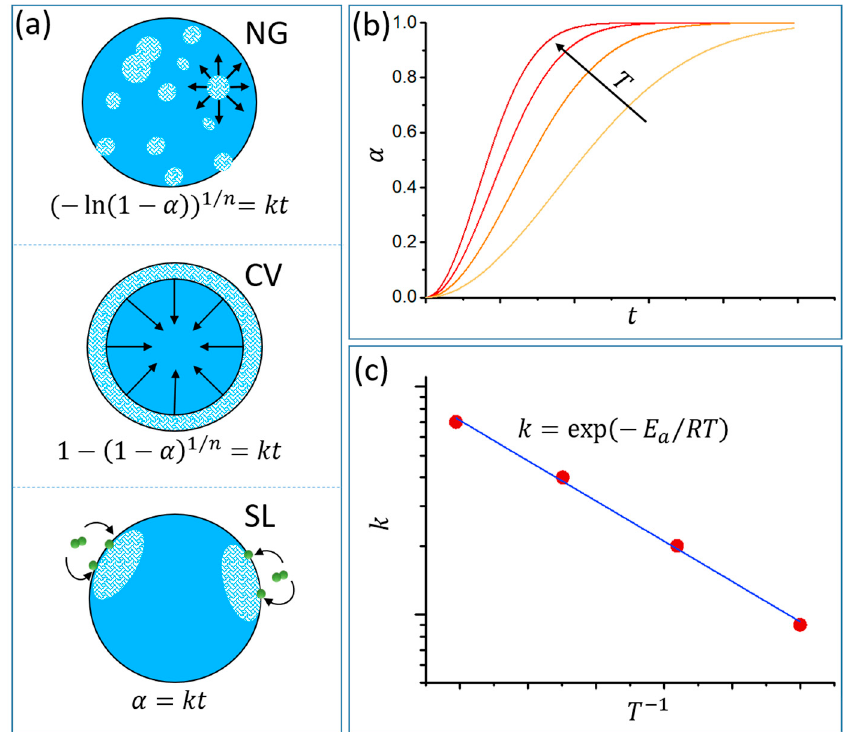
Figure 2. ( a ) Representation of the kinetic models used to analyze the time evolution of the transformed fraction α : nucleation and growth (NG), contracting volume (CV), and surface limited (SL). ( b ) Example of NG kinetics at increasing temperature T . ( c ) Arrhenius plot of the rate constant k , from which the apparent activation energy E a is